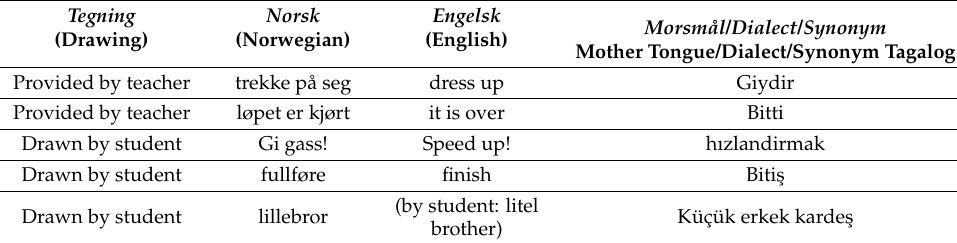
Table 1. Multilingual dictionary with